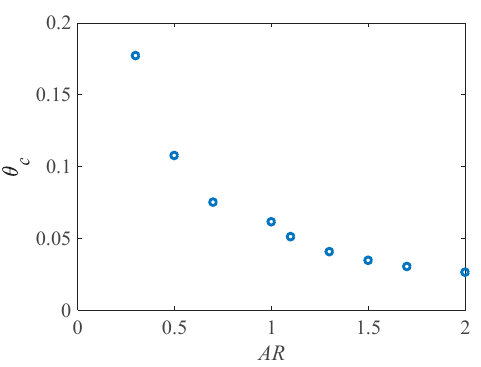
Figure 13. Dimensionless time θ c corresponding to the critical point when the bottom side is heated.